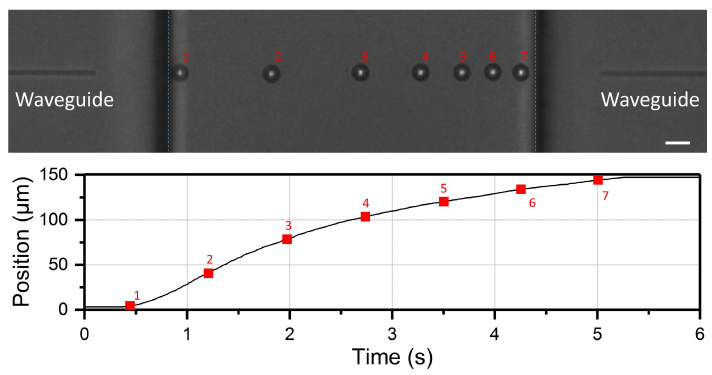
Figure 4. Phase-contrast microscope image stack showing the sequential microbead positions at equal time intervals from an optical shooting experiment. Scale bar: 10 µm. The bright spot in the bead center is used to retrieve the bead position. The extracted shooting trajectory is shown underneath. The red numbers in the two figure panels correspond to the same bead